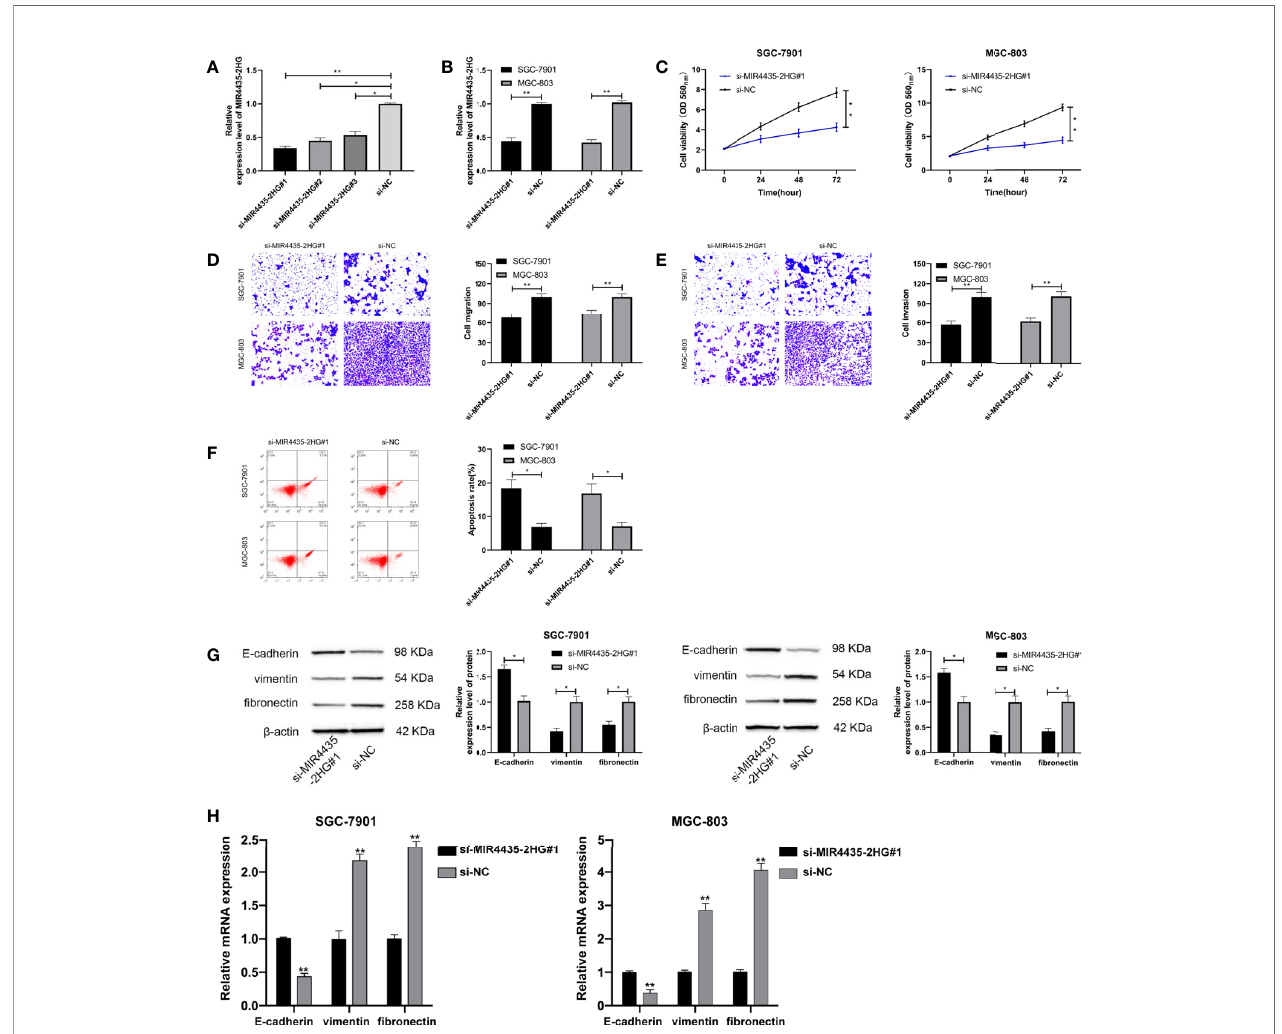
FIGURE 2 | Role of MIR4435-2HG inhibition on growth, metastasis, and epithelial – mesenchymal transition (EMT) of gastric carcinoma cells. (A) qRT-PCR was applied to test MIR4435-2HG after constructing si-MIR4435-2HG in SGC-7901 and MGC-803 cells. (B) qRT-PCR was applied to test MIR4435-2HG in cells transfected with si- MIR4435-2HG#1 in SGC-7901 and MGC-803 cells. (C) Cell Counting Kit-8 (CCK-8) test was applied to test the proliferation of gastric carcinoma cells transfected with si-MIR4435-2HG#1 in SGC-7901 and MGC-803 cells. (D, E) Transwell test was applied to test the invasion and migration of gastric carcinoma cells transfected with si- MIR4435-2HG#1 in SGC-7901 and MGC-803 cells. (F) Flow cytometry was applied to test the apoptosis of gastric carcinoma cells transfected with si-MIR4435-2HG#1 in SGC-7901 and MGC-803 cells. (G) Western blotting experiment was applied to test the changes of EMT protein in cells. (H) qRT-PCR was applied to test the mRNA changes of EMT markers in cells in SGC-7901 and MGC-803 cells. * indicates p < 0.05; ** indicates p <